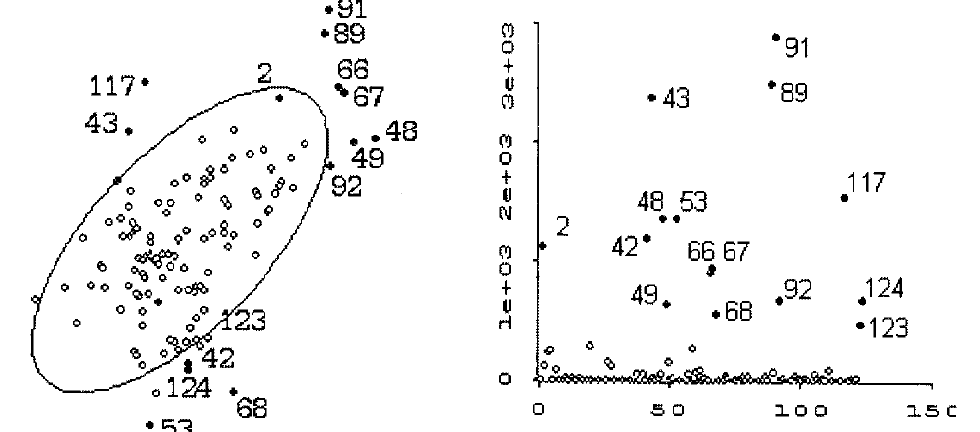
snapshot from the grand tour. Left: An exemplary point projections ellipse superimposed, Right: A linked count-plot illustrating many times (till the the snapshot hand side) each data point was notified beyond the ellipse. 'I'he data points are enumerated according to the Lisp-Stat to